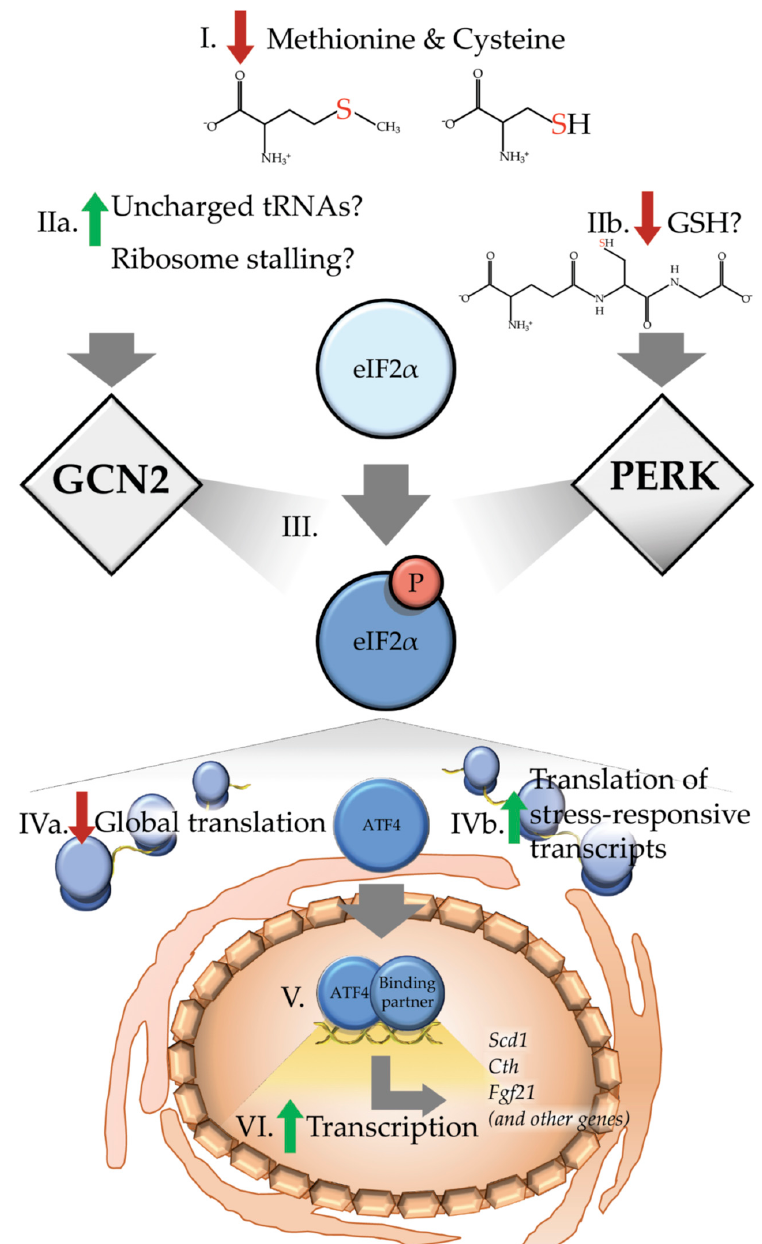
Figure 1. Dietary sulfur amino acid restriction results in activation of the integrated stress response. (I) Upon reduced levels of methionine and cysteine, a canonical integrated stress response (ISR) would predict or hypothesize that (IIa) levels of the uncharged cognate tRNAs may accumulate at or near the ribosome. Alternatively, other recent reports suggest increased ribosome stalling as a potential means of activating the eukaryotic initiation factor 2 (eIF2) kinase general control nonderepressible 2 (GCN2). In addition to activation of GCN2, dietary sulfur amino acid restriction (IIb) reduces levels of intracellular glutathione (GSH), which may in turn activate protein kinase R (PKR)-like endoplasmic reticulum kinase (PERK). Collectively, current evidence suggests that both of these paths results in (III) phosphorylation of the α subunit of eIF2. Phosphorylation of eIF2 (IVa) decreases global translation (IVb) which increases preferential translation of transcripts containing upstream open reading frames such as the basic leucine zipper (bZIP) transcription factor Atf4 . (V) Upon being translated, activating transcription factor 4 (ATF4) enters the nucleus and interacts with binding partners to (VI) induce transcription of target genes, including stearoyl-Coenzyme A desaturase 1 ( Scd1 ), cystathionine gamma-lyase ( Cth ) and fibroblast growth factor 21 ( Fgf21 ), as well as many other